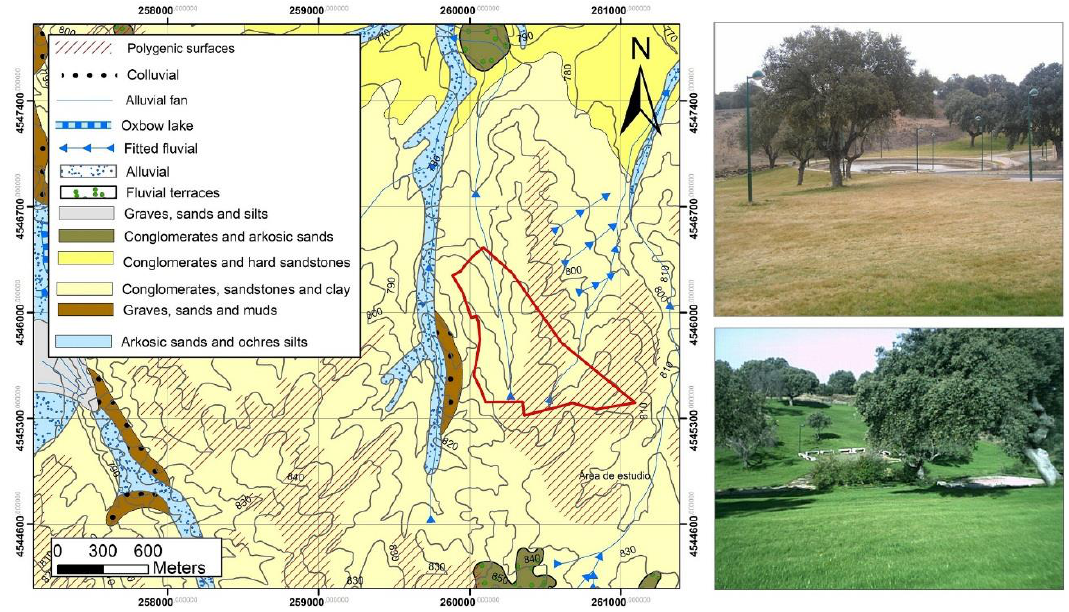
Figure 3. Distribution of geomorphological units in the study area.